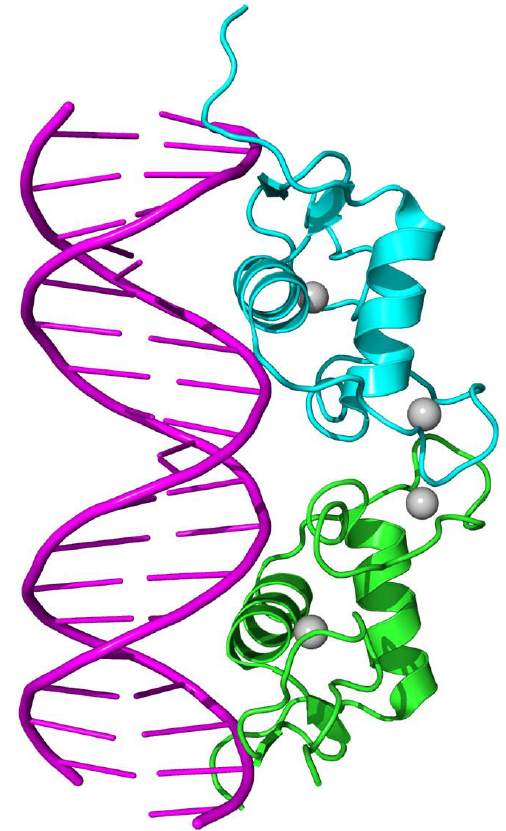
Figure 1. An illustration to show a nuclear receptor binding to